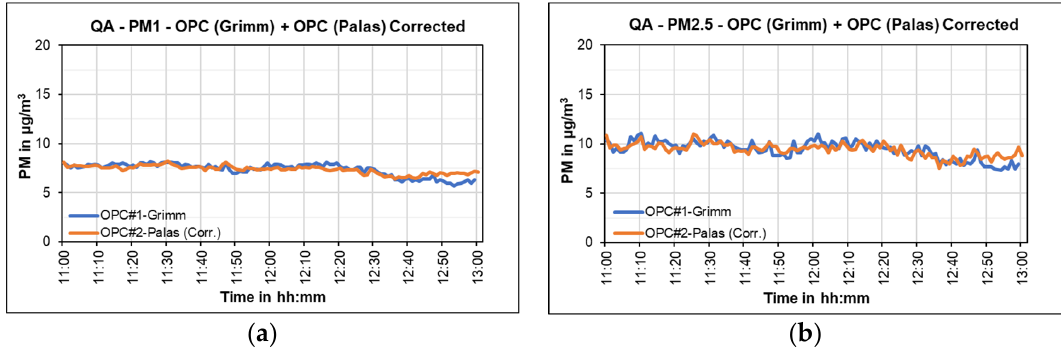
Figure 31. Comparison of ( a ) PM1 and ( b ) PM2.5 after applied correction.